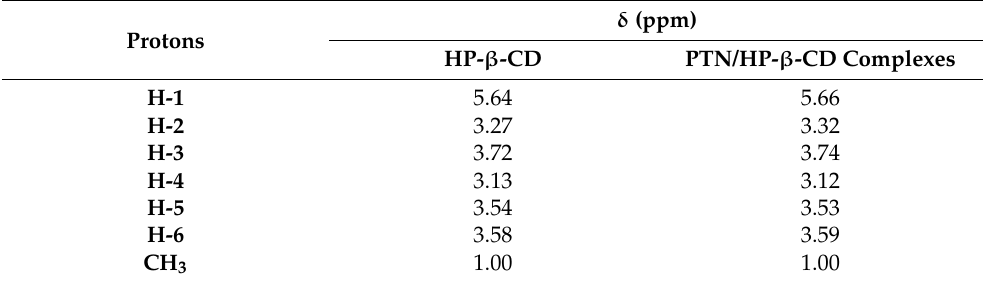
Figure 2. 1 H NMR spectra of ( A ) PTN, ( B ) HP- β -CD, and ( C ) the PTN/HP- β -CD complexes in DMSO-d 6 . Table 1. Selected chemical shifts ( δ in ppm) of HP- β -CD and PTN/HP- β -CD complexes in